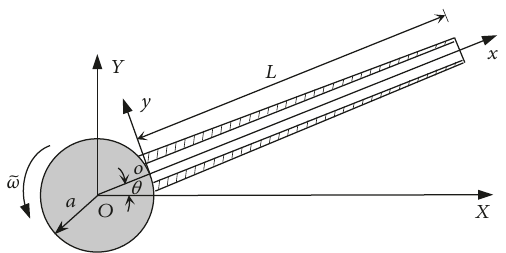
Figure 1: Schematic diagram of a rotating tapered cantilever beam with hollow circular